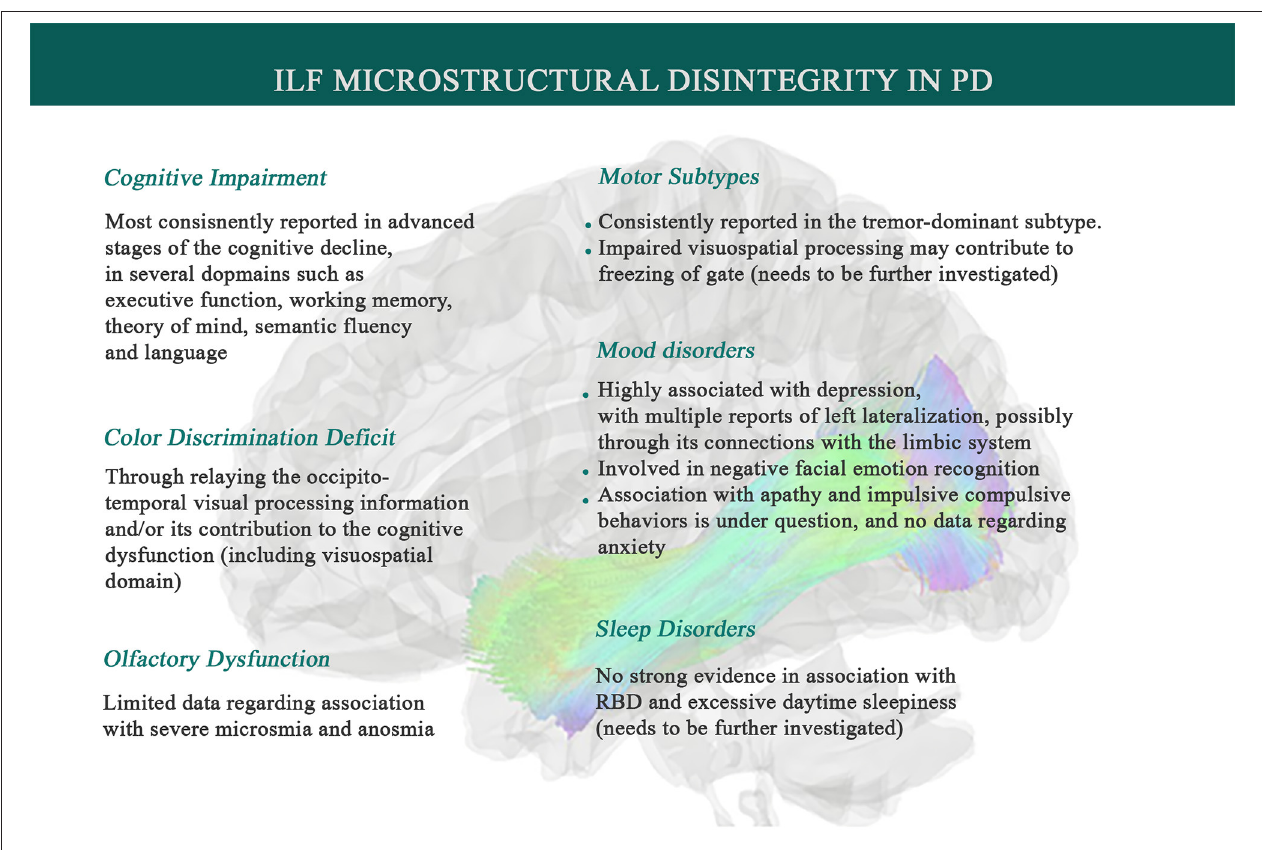
FIGURE 2 | Associations between Inferior Longitudinal Fasciculus microstructural changes and Parkinson’s disease symptomatology. Data suggests that systemic inflammation can lead to ILF disintegrity, exhibited by higher mean diffusivity (MD) and lower fractional anisotropy (FA), and thereby contributes to PD symptoms such as a range of cognitive impairments, depression, olfaction dysfunction, facial emotion recognition deficit, color discrimination deficit, and tremor genesis. ILF also has been inconsistently shown to play a role in sleep disorders (like RBD), impulsive compulsive behaviors, and freezing of gate, which needs to be further